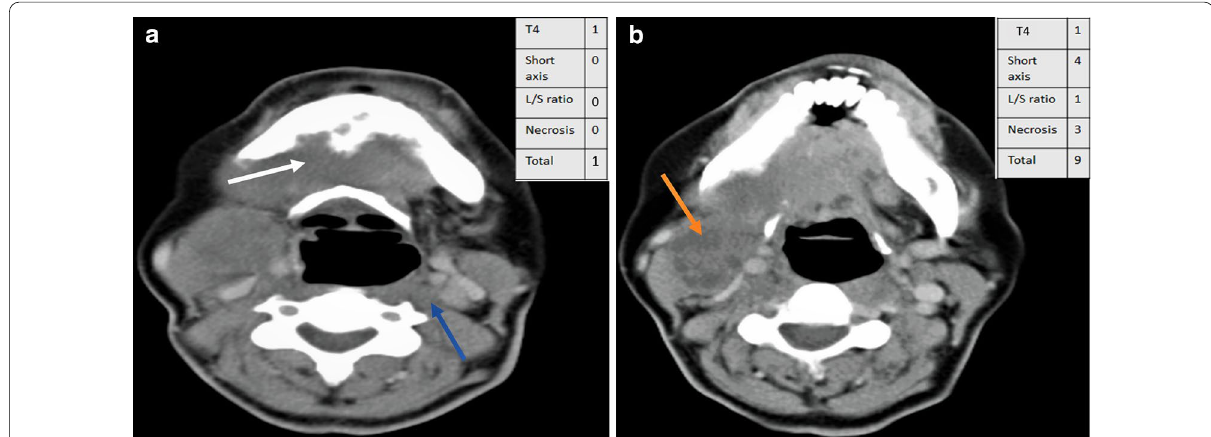
Fig. 4 A 46-year-old female patient with right side floor of the mouth SCC suffered from RT mandibular swelling. Contrast-enhanced MDCT neck a axial view shows ill-defined infiltrating soft tissue mass intimately related to the right mandibular body measures about 40 submental extension and eroding the mandibular body on both sides (white arrow), and LT side LN enlargement at level II measures 7 (score 1) (sky blue arrow). b Axial view shows RT side LN enlargement at level III measures 42 Histopathology confirmed the node to be malignant at level III and benign at level II